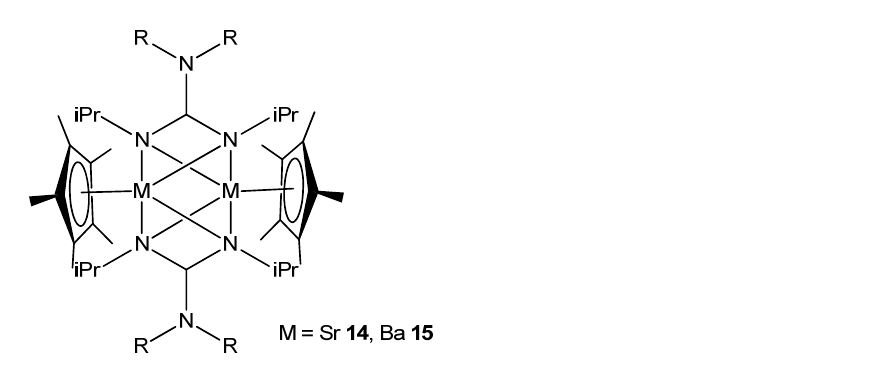
Figure 9. Heteroleptic benzylcalcium complex as the product of Schlenk equilibrium.